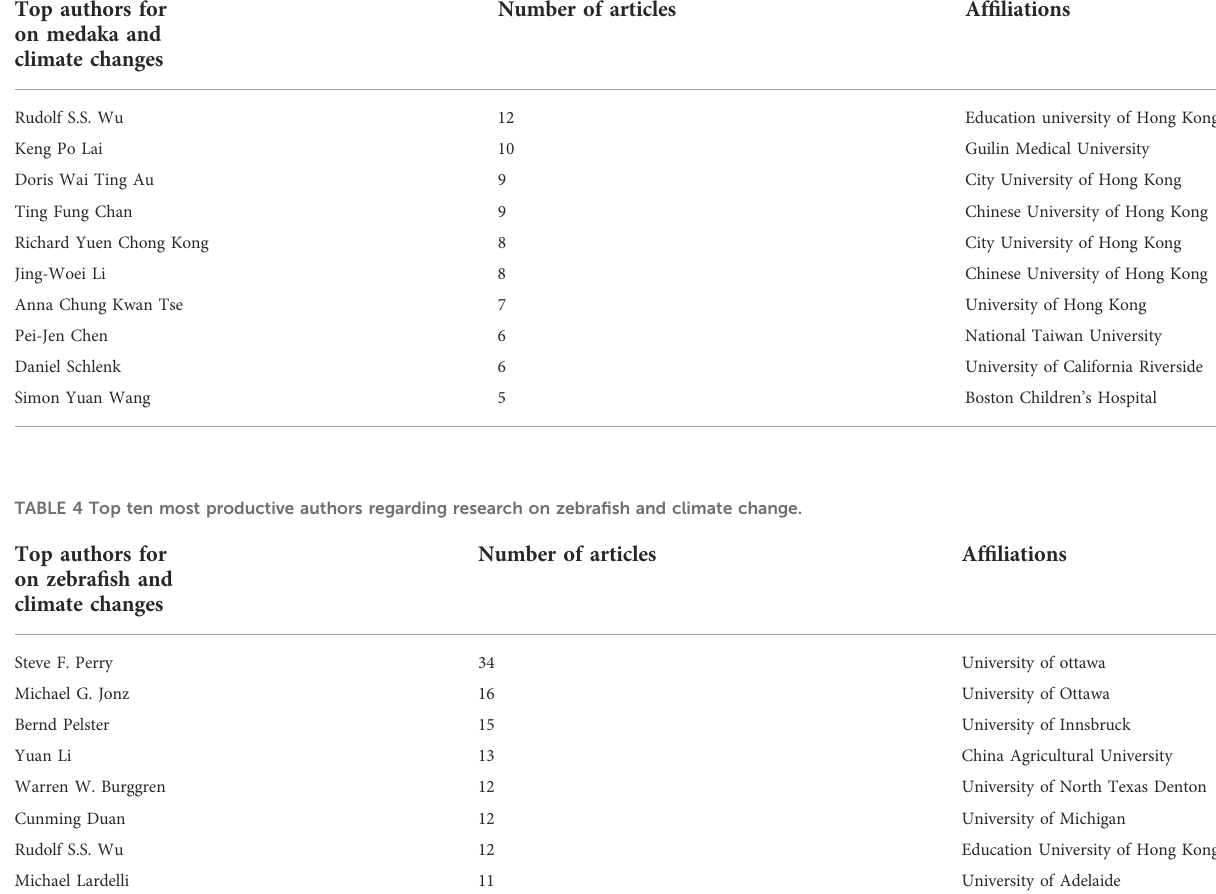
TABLE 3 Top ten most productive authors regarding research on medaka and climate change.